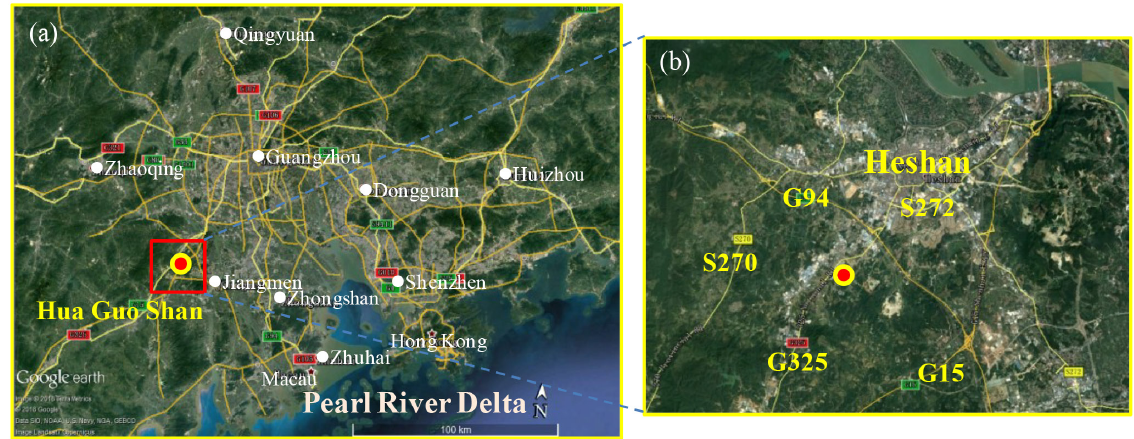
Figure 1. (a) Google map images of the Pearl River Delta in Guangdong Province and the measurement site (Hua Guo Shan). (b) The topography and major roads (shown by number) adjacent to the measurement